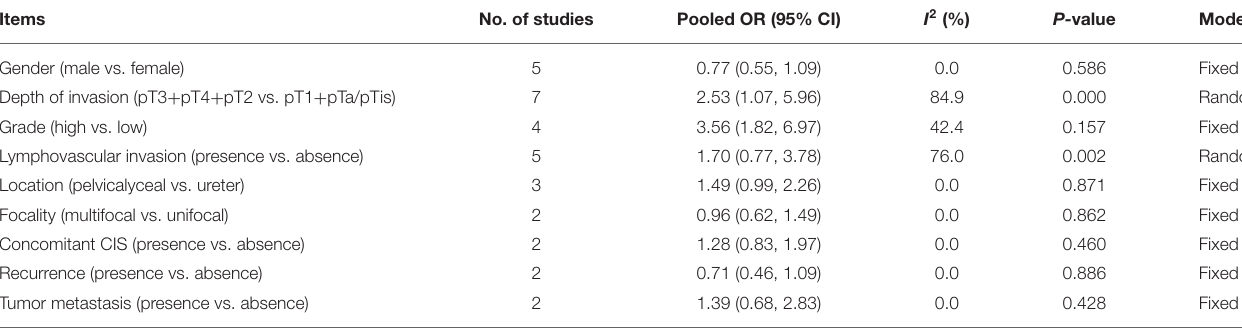
TABLE 3 | Association between PD-L1 expression and clinicopathological features of